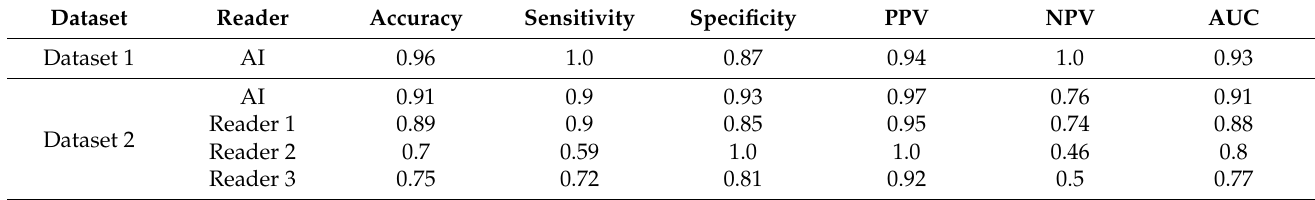
Table 2. Accuracy, sensitivity, specificity, Negative Predictive Value (NPV), Positive Predictive Value (PPV) and AUC of our AI-based approach. AUC represents the area under the Receiver Operating Characteristic (ROC) curve.